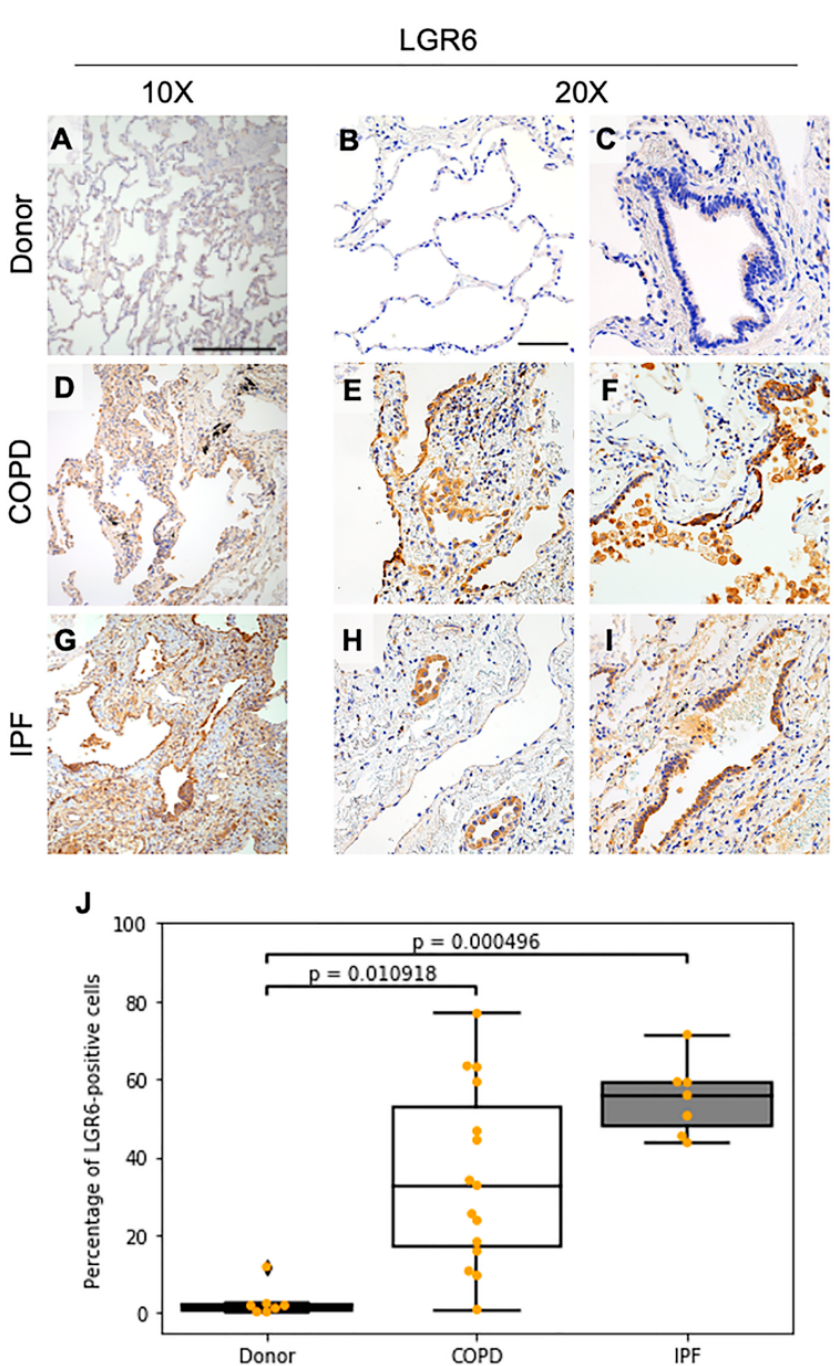
Figure 1. Immunohistochemical stainings depict high LGR6 protein levels in COPD and IPF tissues. ( A – I ): Immunohistochemical images representative of human donor, COPD and IPF lungs stained at 10 × ( A , D , G ; scale bar = 300 µ m) and at 20 × (bar = 100 µ m) magnification to detect localization of LGR6 in alveolar ( B , E , H ) and bronchiolar ( C , F , H ) areas. ( J ): Quantification of LGR6-positive cells for donor ( n = 7), COPD ( n = 15) and IPF ( n = 7) tissues. Statistics: non-parametric ANOVA ( p donor vs. COPD = 0.010918, p donor vs. IPF = 0.010918 and p COPD vs. IPF = 0.408217).